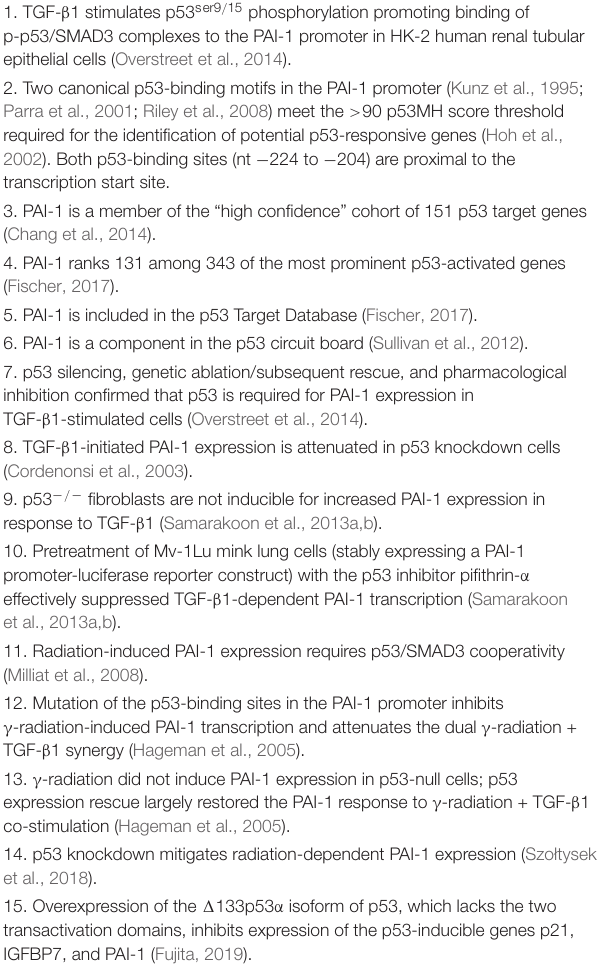
TABLE 1 | Summary of p53 involvement in expression of the target PAI-1 gene. 1. TGF- β 1 stimulates p53 ser9 / 15 phosphorylation promoting binding of p-p53/SMAD3 complexes to the PAI-1 promoter in HK-2 human renal tubular epithelial cells (Overstreet et al.,